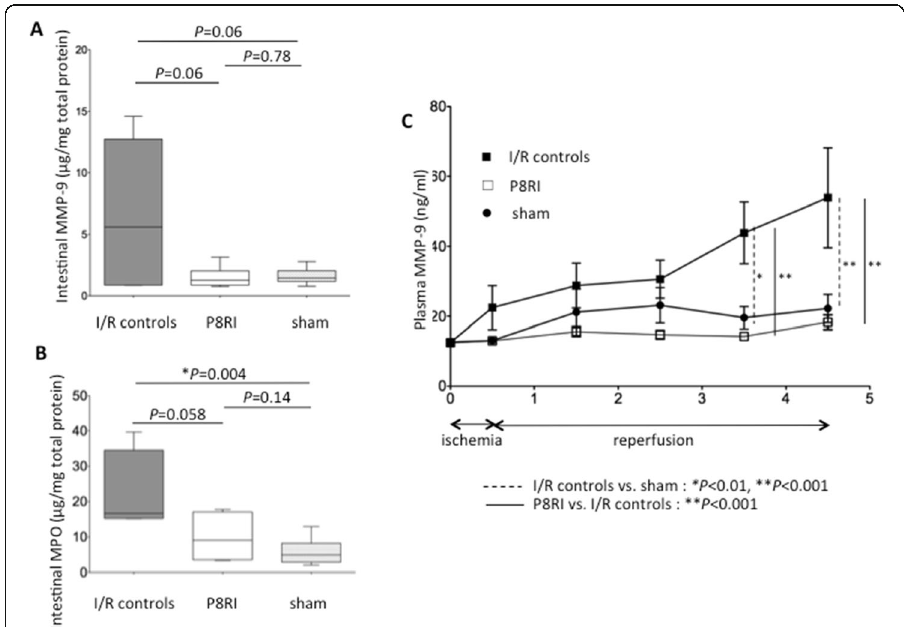
Fig. 2 Effect of P8RI on mesenteric ischemia/reperfusion-induced neutrophil activation. Mesenteric ischemia/ reperfusion-induced neutrophil activation was assessed by the detection of MMP-9 and MPO release in the small bowel tissue and plasma. a , b The concentrations of MMP-9 and MPO in the intestinal tissue were almost significantly lower in the P8RI group than in I/R controls ( P =0.06 and P =0.058, respectively). c The plasma concentration of MMP-9 was lower in the P8RI group than in I/R controls at 3 h (** P < 0.001) and 4 h (** P < 0.001) of reperfusion after mesenteric ischemia. MMP-9: matrix